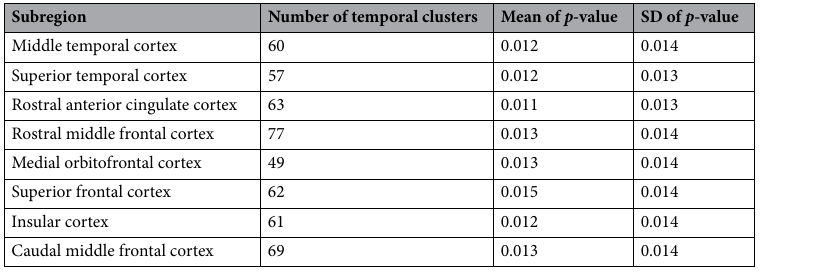
Table 2. Statistics of significant temporal clusters in the comparison between iEEG sampled around phrase boundaries and reference windows within each subregion in all twelve